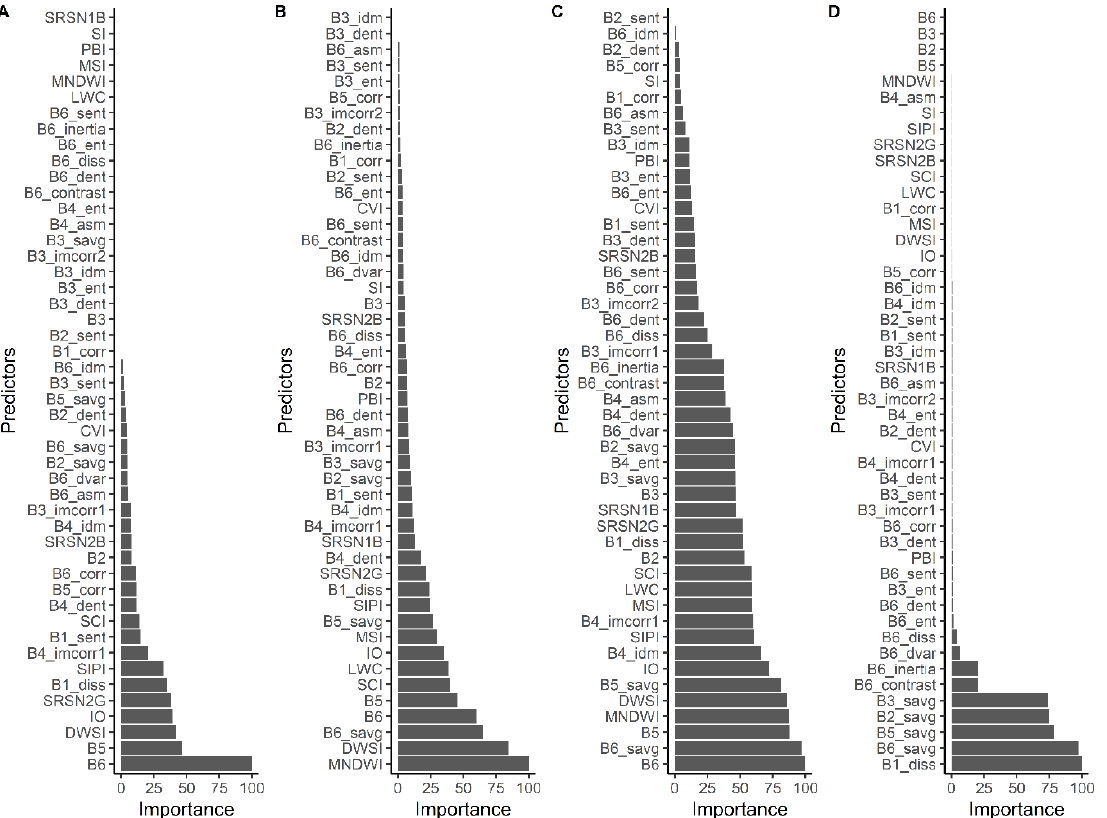
Figure 3. Importance value of predictors in each of the four modeling techniques based on 10 ‐ fold cross-validation with 10 times repetition. The codes after band (e.g., B6_savg) and other predictors were explained in Table 2. ( a ) Stochastic gradient booting; ( b ) random forest; ( c ) support vector machine; ( d ) partial least square regression.